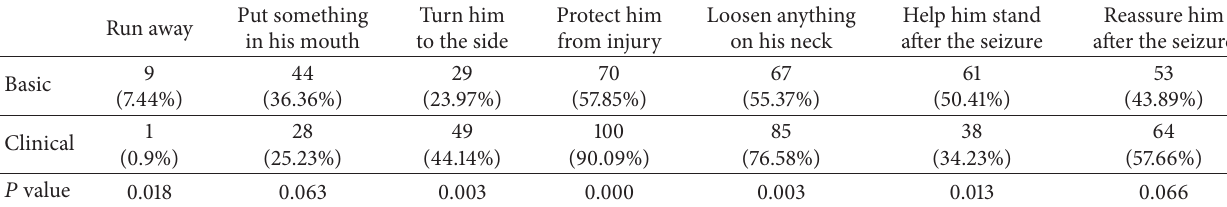
Table 2: Reaction to a person having seizures.